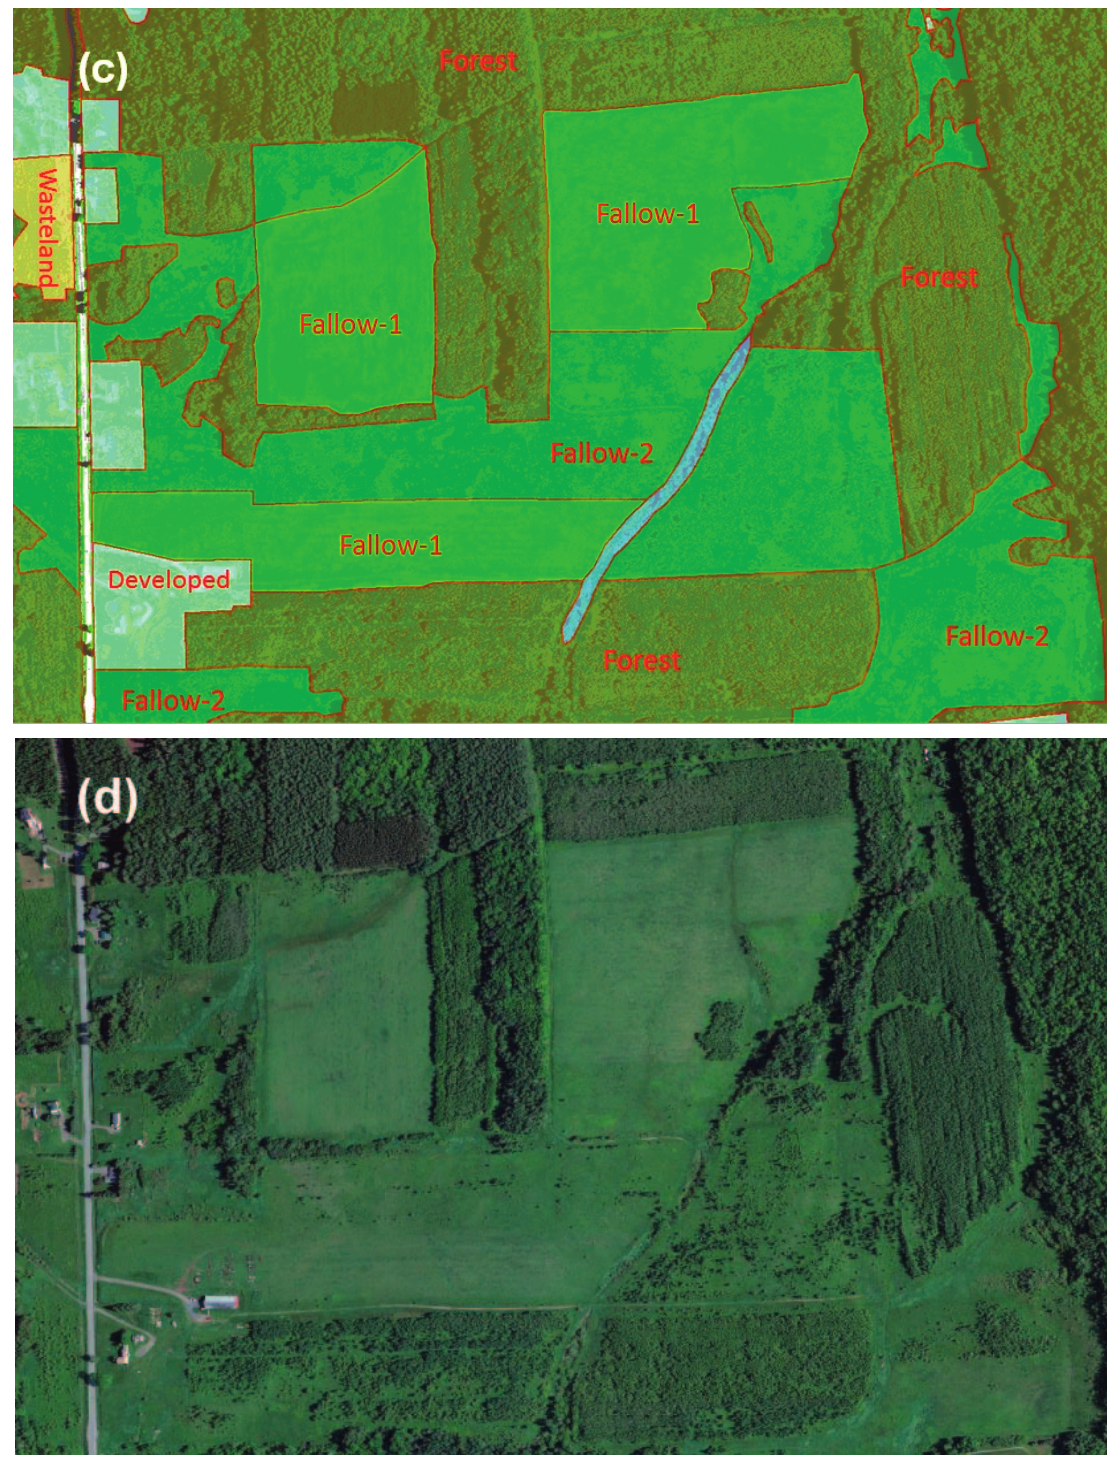
Figure 4. Sample images of the same location and extent showing CIR data classification and interpretation of land use. ( a ) CIR imagery; ( b ) classified CIR imagery; ( c ) land-use map (overlaying on classified CIR); ( d ) visible light, true-color